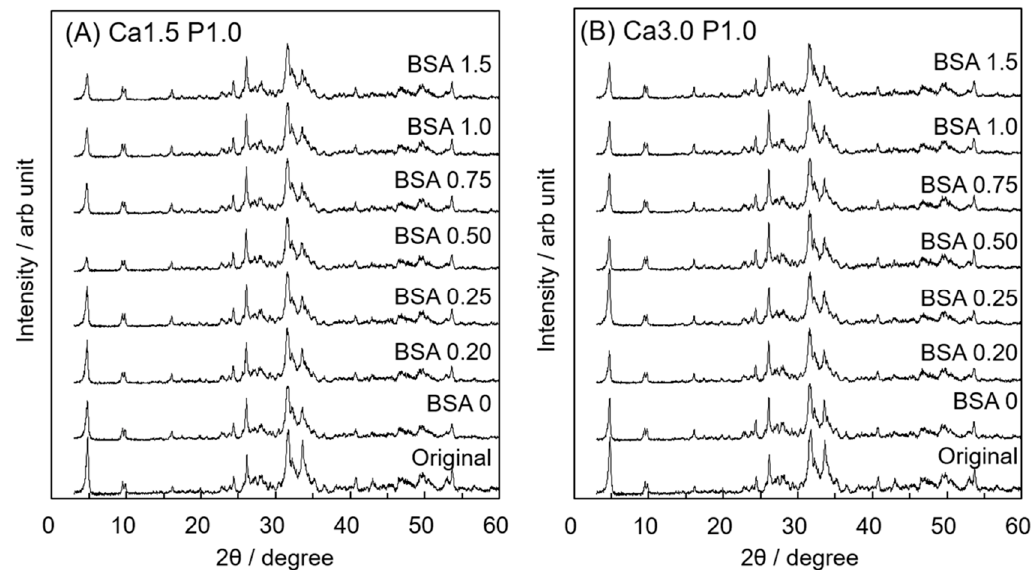
Figure 3. Powder XRD patterns of OCP before and after incubation with 0 to 1.5 mg·mL − 1 BSA in Ca1.5P1.0 ( A ) or Ca3.0P1.0 ( B ) solutions.